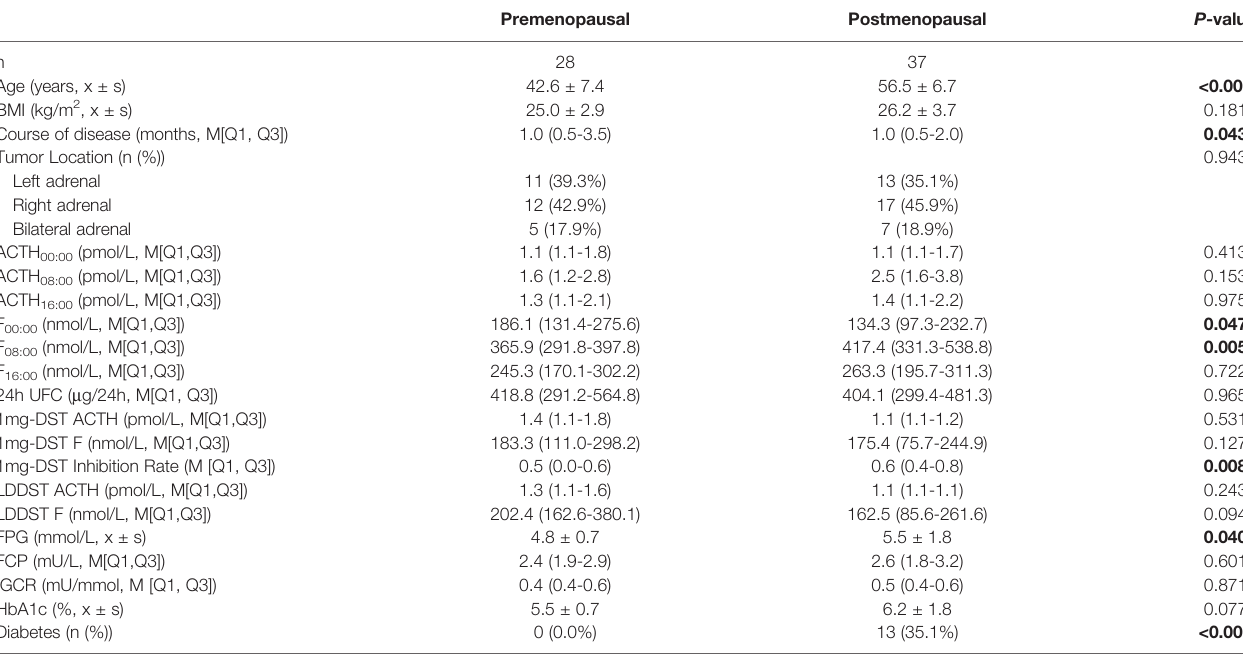
Premenopausal Postmenopausal